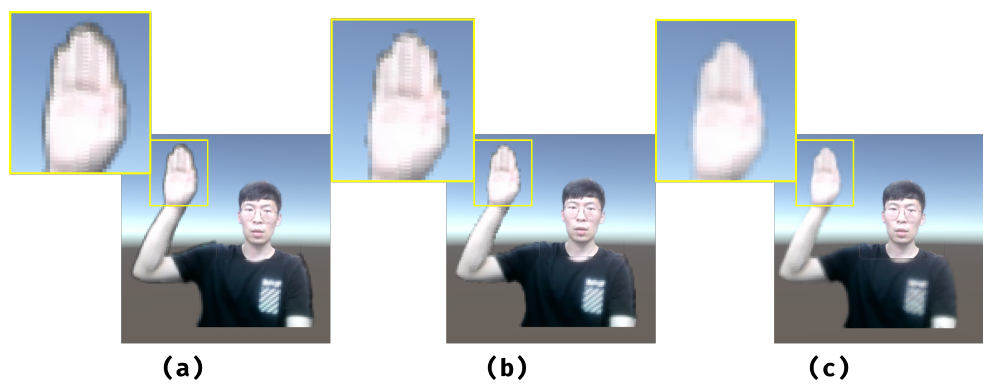
Figure 5. ( a ) Downsampling-only body point cloud. ( b ) Result of subtracting the edge detection results from the alpha channel of ( a ). ( c ) Histogram equalization on the alpha channel of ( b ).